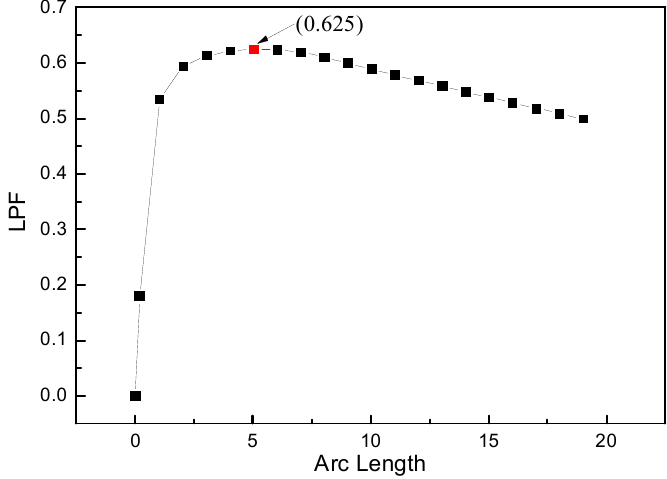
Figure 7. Arc length—LPF curve.